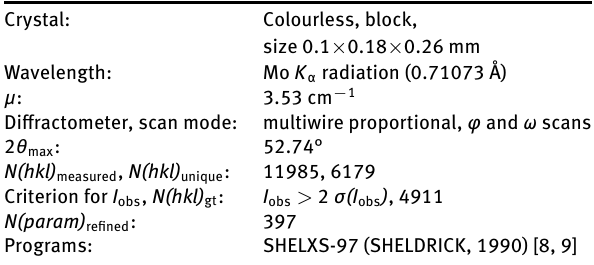
Table 2: Fractional atomic coordinates and isotropic or